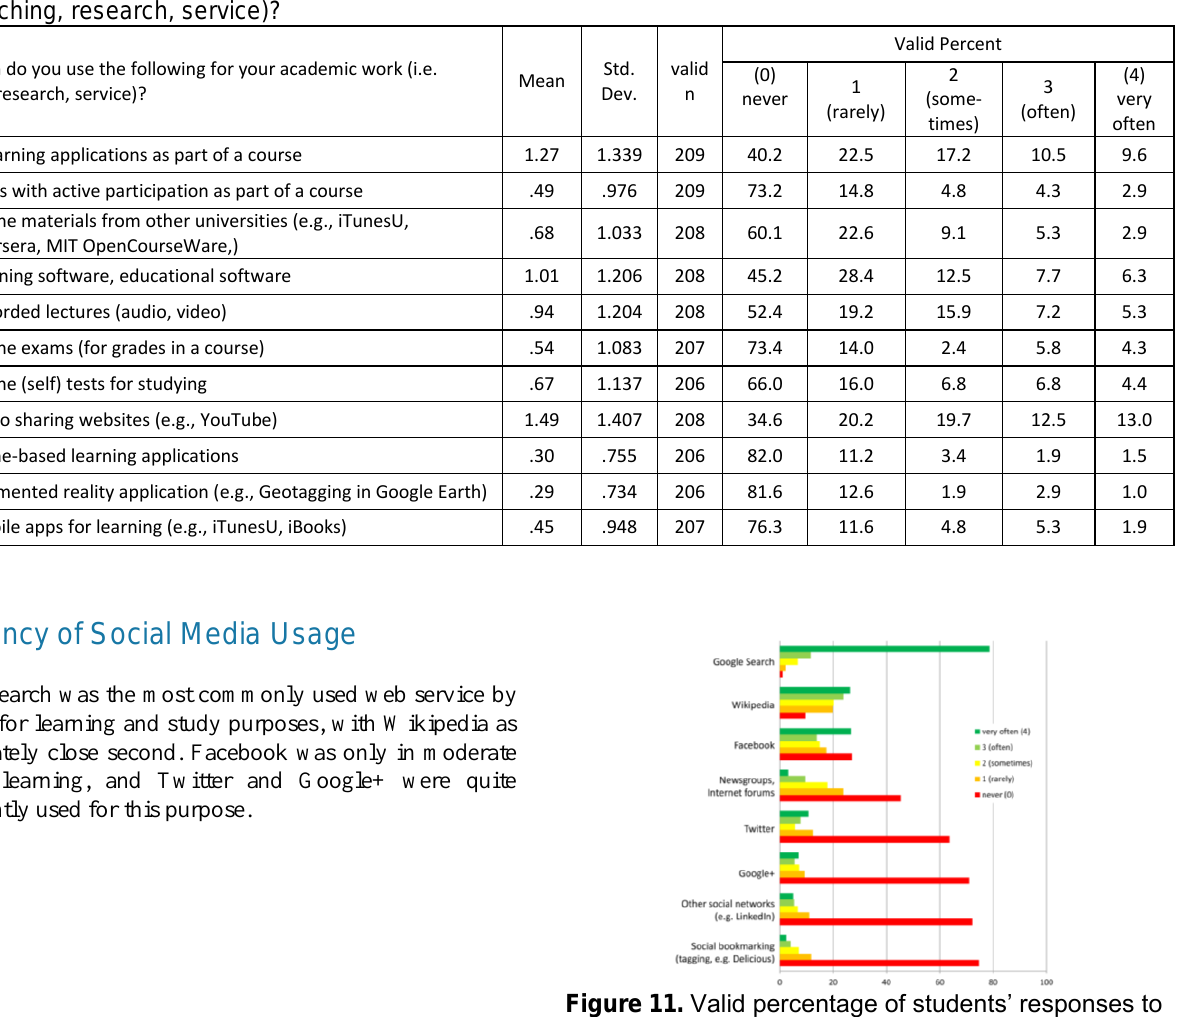
Table 9 . Instructors’ responses to the question: How often do you use the following for your academic work